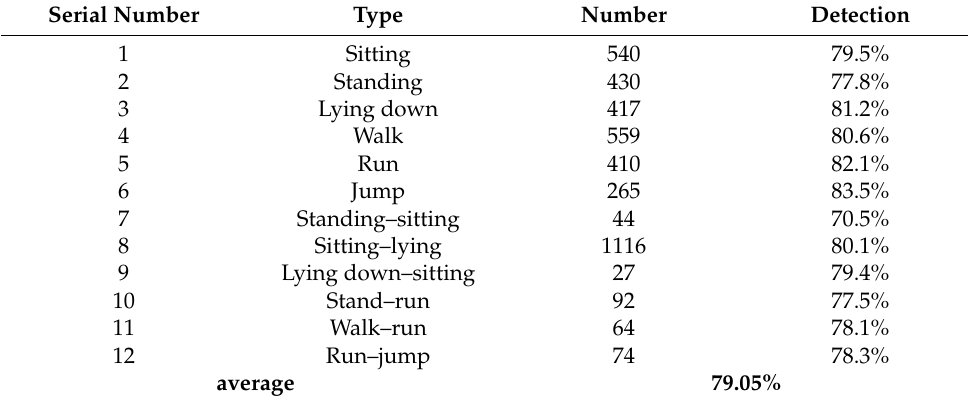
Table 8. Distribution of human behavior detection results under machine